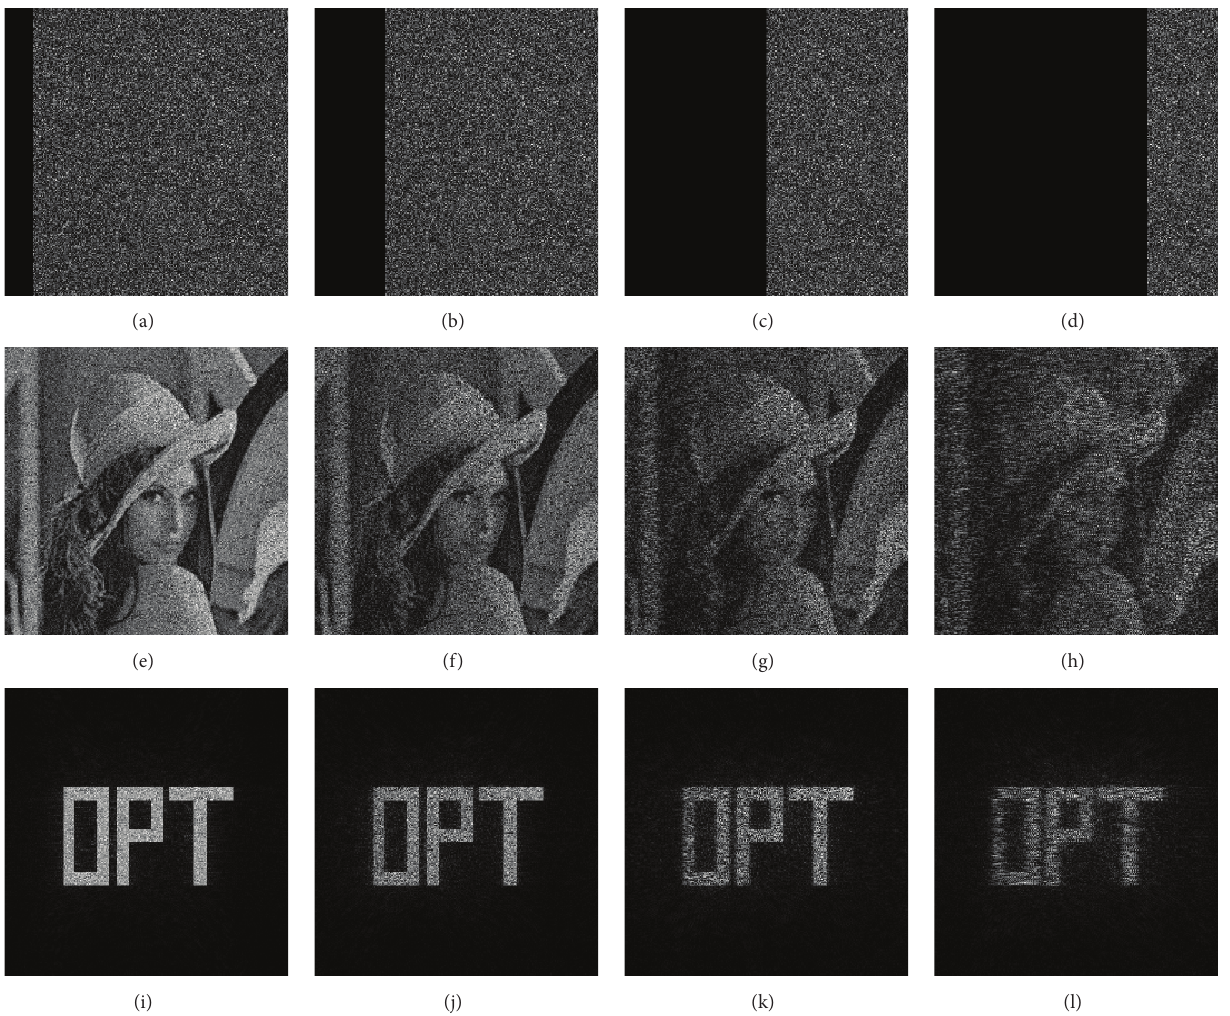
Figure 9: Occlusion results for the grayscale and the binary image for varying degrees of occlusion: encrypted image with (a) 10% occlusion, (b) 25% occlusion, (c) 50% occlusion, (d) 75% occlusion, (e–h) corresponding recovered grayscale images, and (i–l) corresponding recovered binary